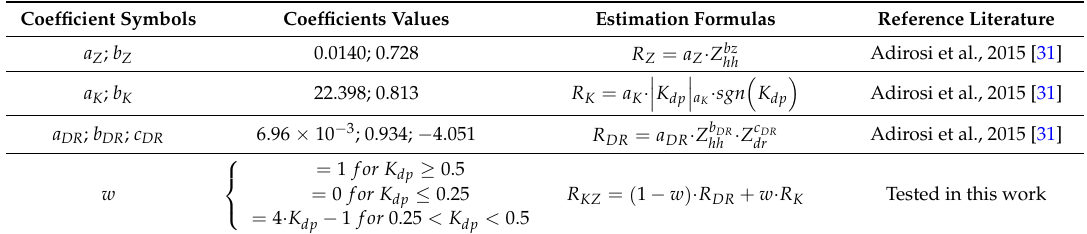
Table 1. Coefficients used for rain estimations in Equations